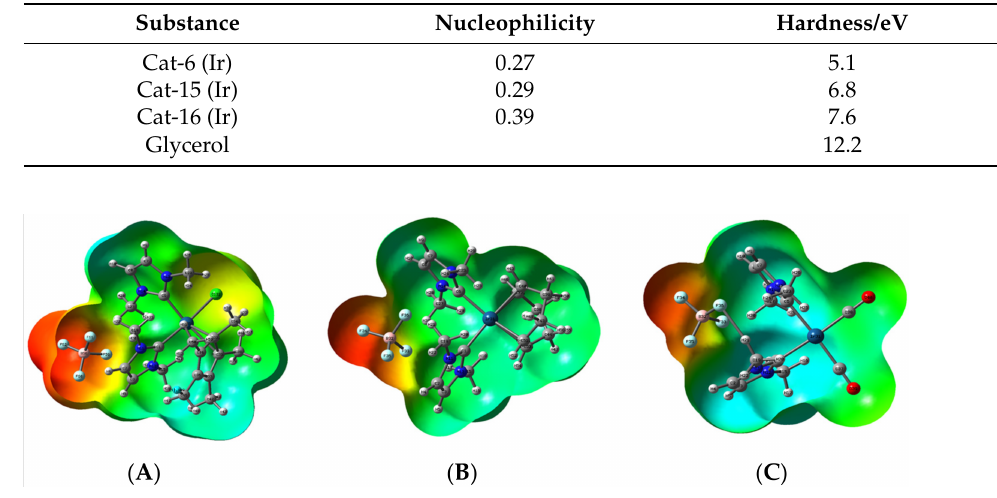
Figure 7. ( A ) The electrostatic potential (ESP) diagram of cat-6; ( B ) the ESP diagram of cat-15; ( C ) the ESP diagram of cat-16.